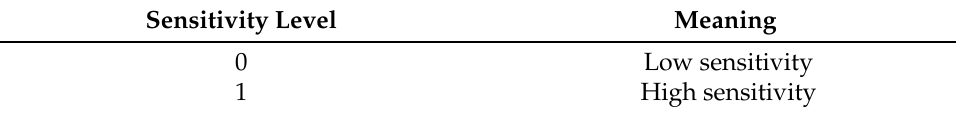
Table 2. Sensitivity